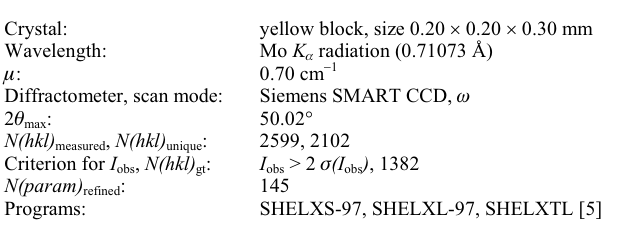
Table 1. Data collection and handling.